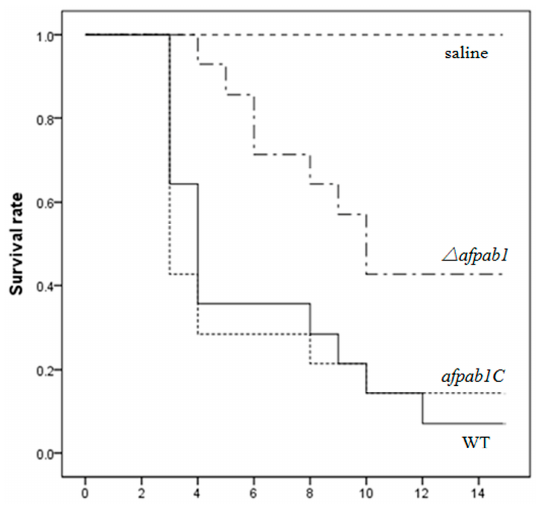
Figure 11. Kaplan-Meier analysis showed that survival rate of mice infected with Δ afpab1 was significantly higher than the WT and afpab1C ( p < 0.05).